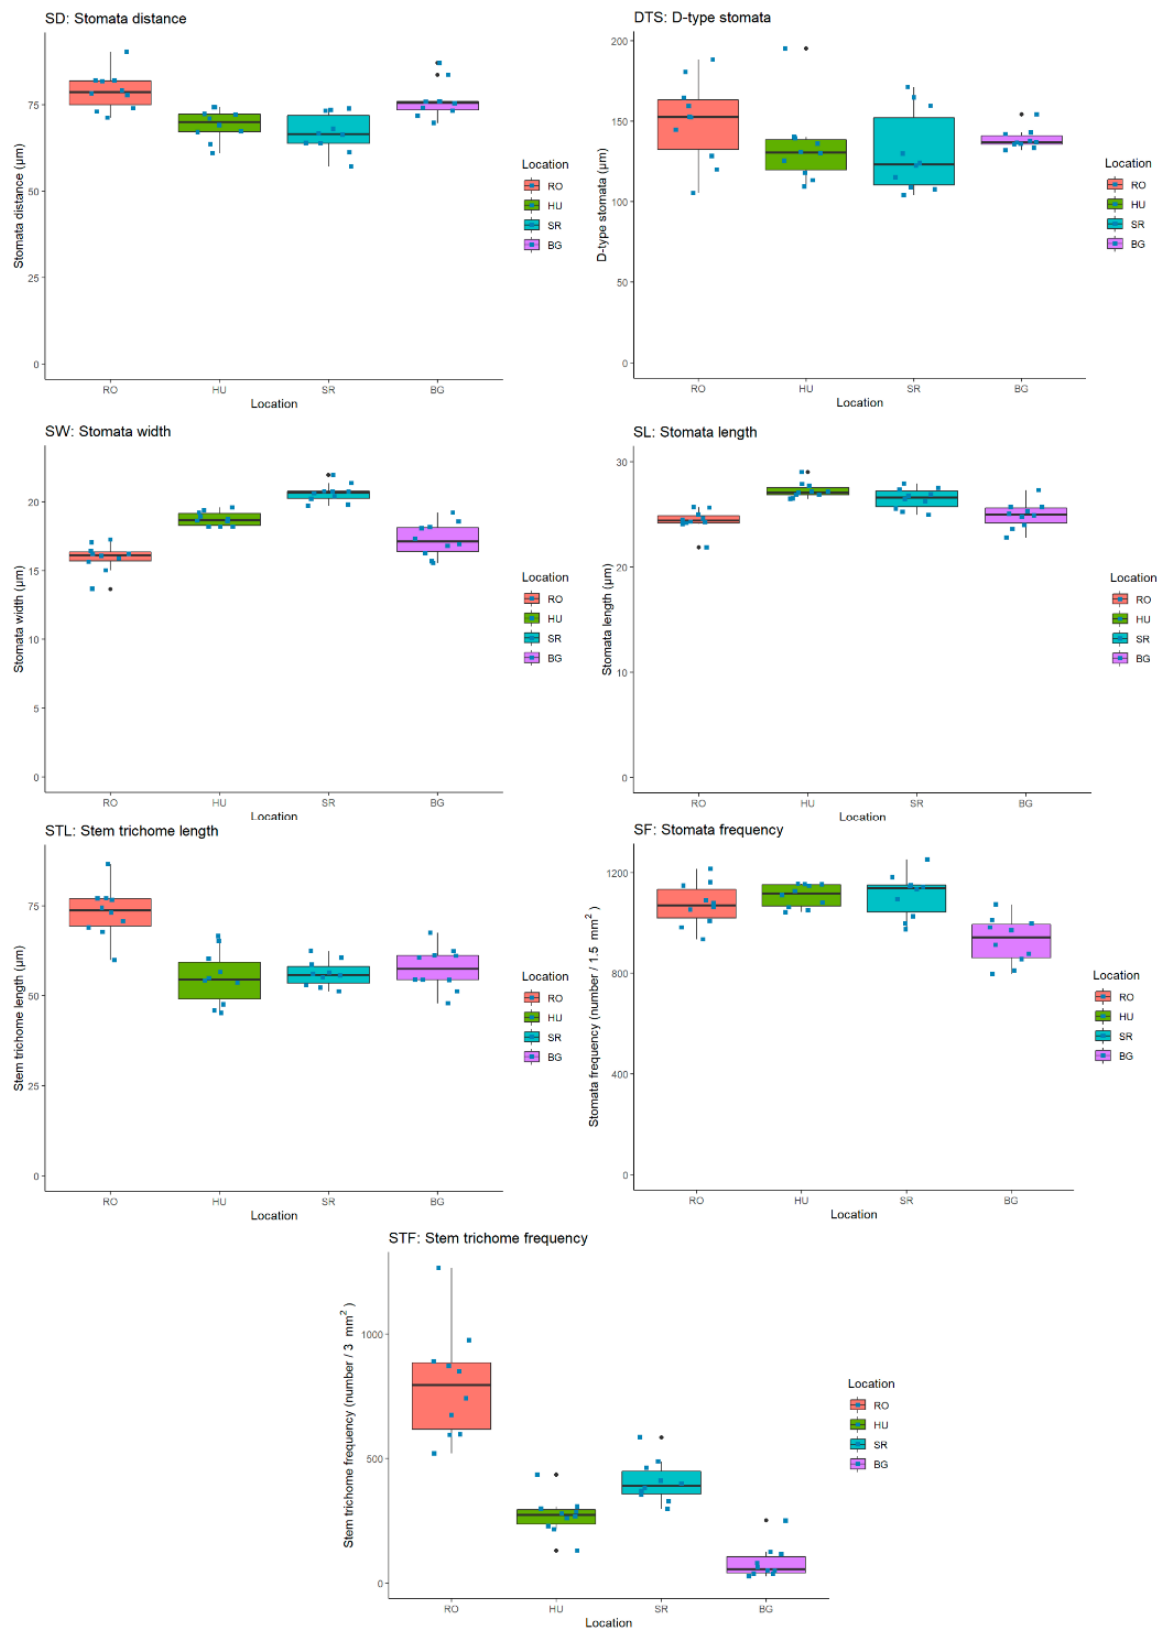
Figure 6. MT-specific median value ranges for all four populations (RO, HU, SR and BG).